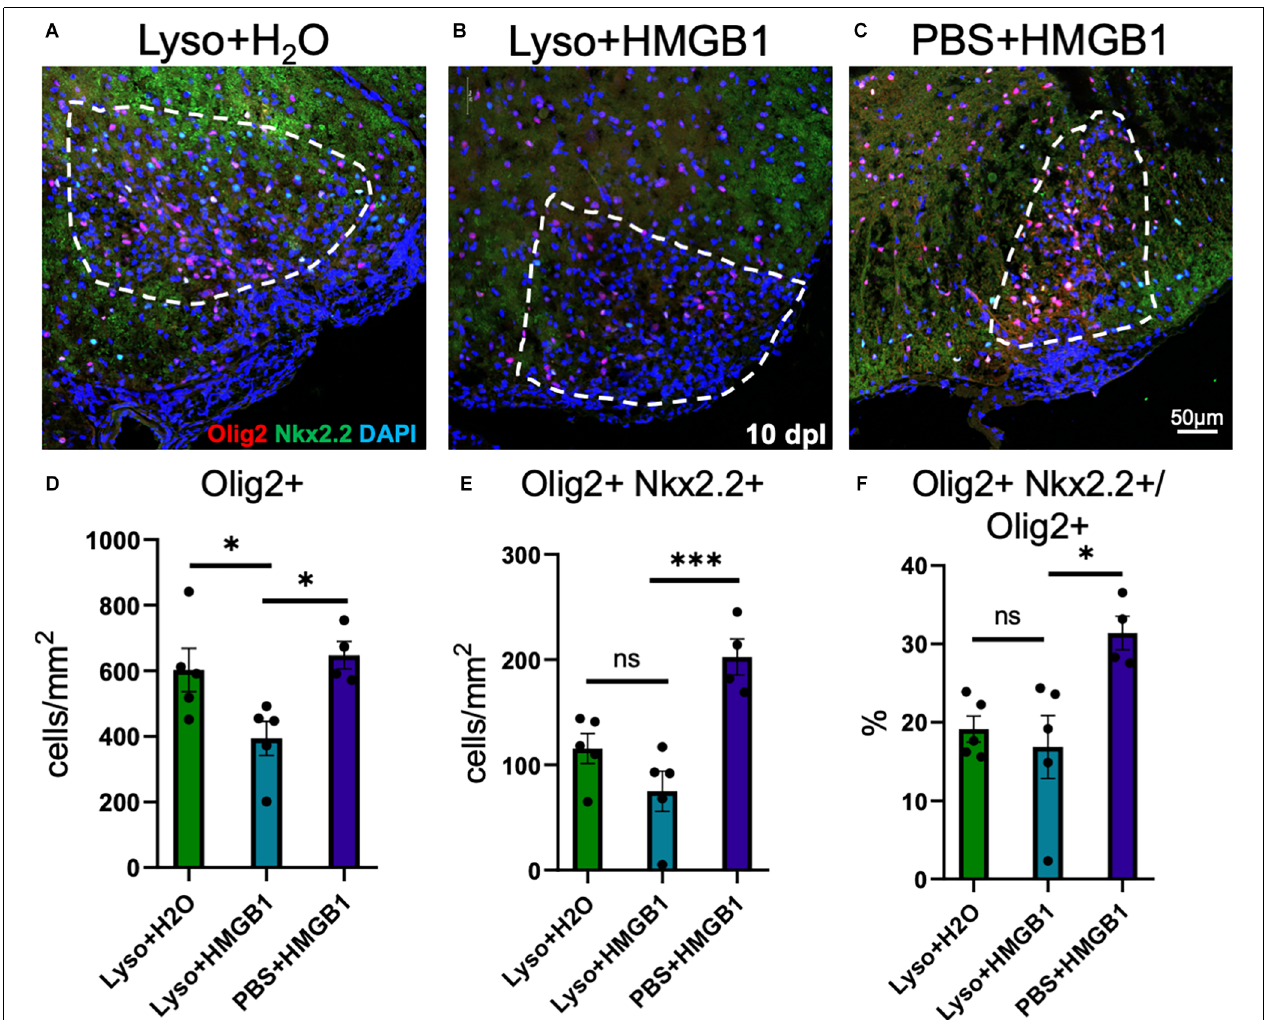
FIGURE 2 | HMGB1 delayed maturation of oligodendrocytes in vivo . (A) A representative IHC image of mouse spinal cord injected with 1 µ l LPC (1.0%) and water control 10 dpl stained for Olig2, Nkx2.2, and DAPI. (B) A representative IHC image of mouse spinal cord co-injected with 1 µ l LPC (1.0%) and 1 µ l rhHMGB1 (1 mg/ml in water) at 10 dpl stained for Olig2, Nkx2.2, and DAPI. (C) A representative IHC image of mouse spinal cord injected with 1 µ l rhHMGB1 (1 mg/ml in water) 10 days post injection stained for Olig2, Nkx2.2, and DAPI. (D – F) Quantification of lesions, including Olig2+ cells, Olig2+, and Nkx2.2+ cells and the percent of Olig2+ cells that were also Nkx2.2+. White lines indicate lesion/injection site. Two to six spinal cord sections from each mouse were used for quantification, 3–5 mice per condition. ∗∗∗ P ≤ 0.001 and ∗ P ≤ 0.05. ns when P > 0.05. Scale bar = 50 µ